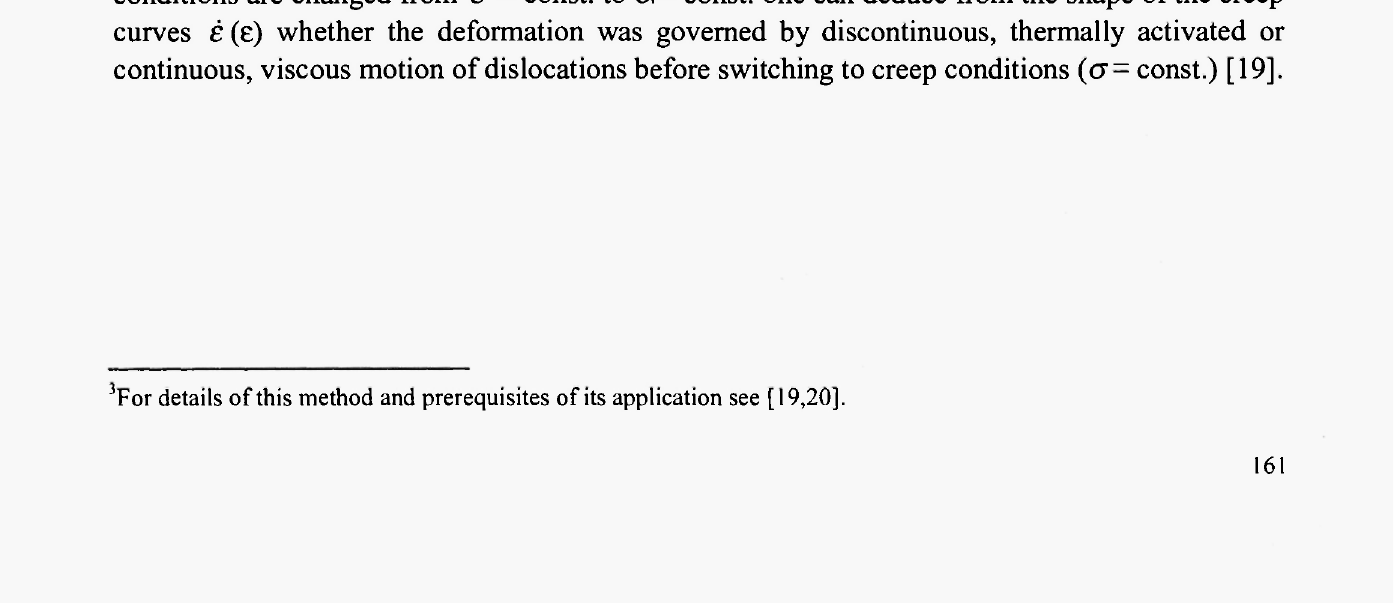
) of Cu 10at%Al on stress (σ-σ s